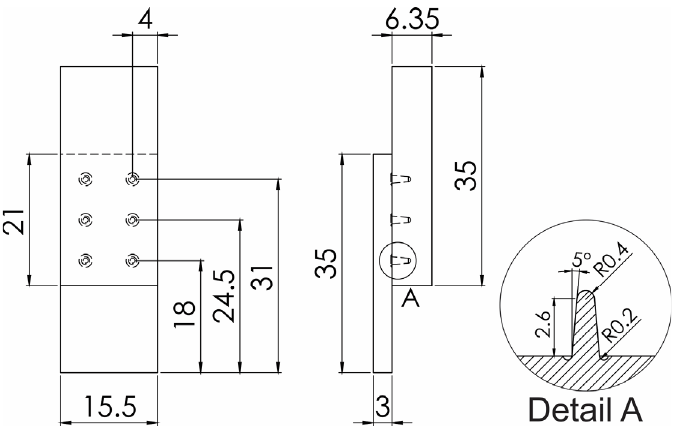
Figure 2. Geometry dimensions of the single lap-shear specimens used in this work, including a detailed view of the TTR dimensions. All dimensions are given in mm. Adapted with permission from [8], Elsevier, 2022.